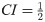
Markov chain diagrams and contrast index.Markov chain diagrams are shown (the size of circle means of occupancy state rate and the arrow’s width are proportional to the probability of cooperate given (A) occupancy state and transition probabilities for an animal that disrupted its cooperative behavior when contrast index CI=12 was changed to CI=23 and pay-off matrix was changed [PT, PR, PP, PS] = [3p, 1p, 4s, 8s] to [5p, 1p, 4s, 8s] (p = pellet and s = seconds). The thickness of blue arrows (conditional probabilities of cooperation) become thinner after change (for values see Table 1). (B) The opposite situation can be seen, non-cooperative animal becomes more cooperative when CI=12 was decreased to CI=15 in a matrix that favors cooperation. The blue arrows become thicker after change (for values see Table 1). (C, D) shows cooperation and timeout levels as a function of CI. Here, it can be seen that both variables follow an inverted U profile in correlation with the contrast index increase and if the payoff matrix favors or not the cooperation behavior.